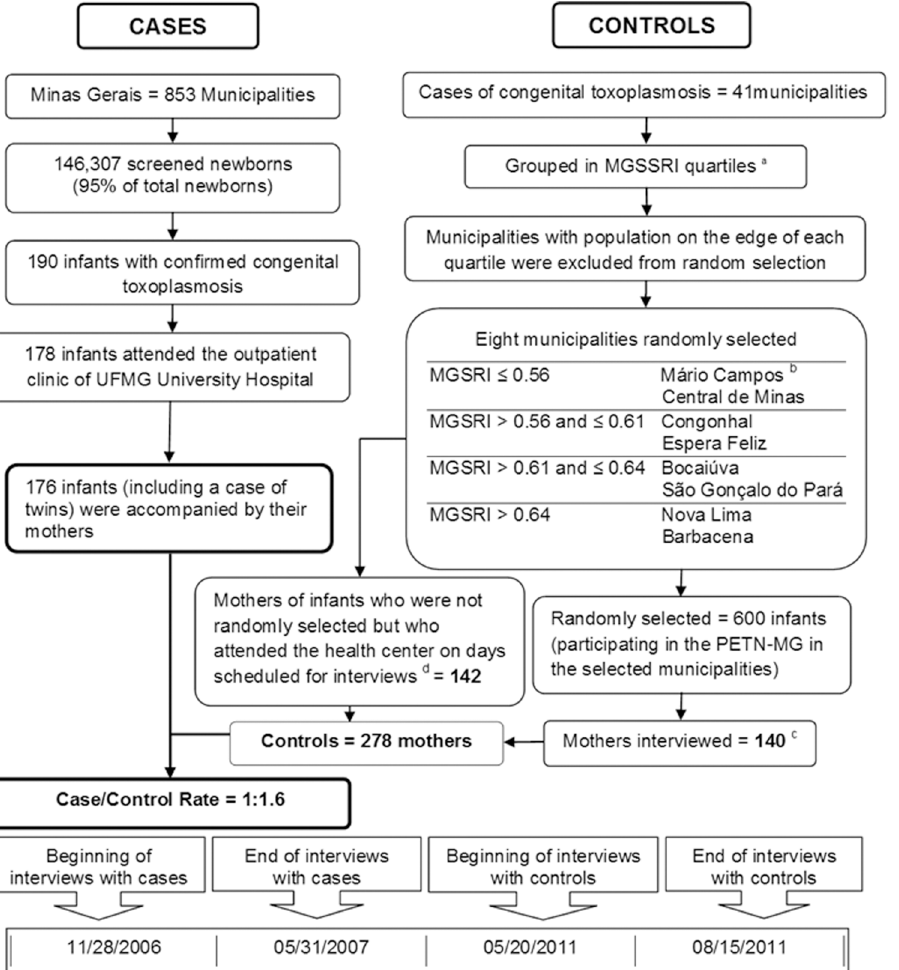
Figure 1. Flow chart of the case-control study for assessment of risk factors for congenital toxoplasmosis in the State of Minas Gerais. a Minas Gerais State Social Responsibility Index. b Municipality from the same stratum that replaced Joaı´ma due to unsuccessful contact. c Four mothers/children were excluded due to suspected gestational/congenital toxoplasmosis. d Included mothers of children aged up to six months. In Barbacena, interviews took place at the central vaccination center of the municipality.